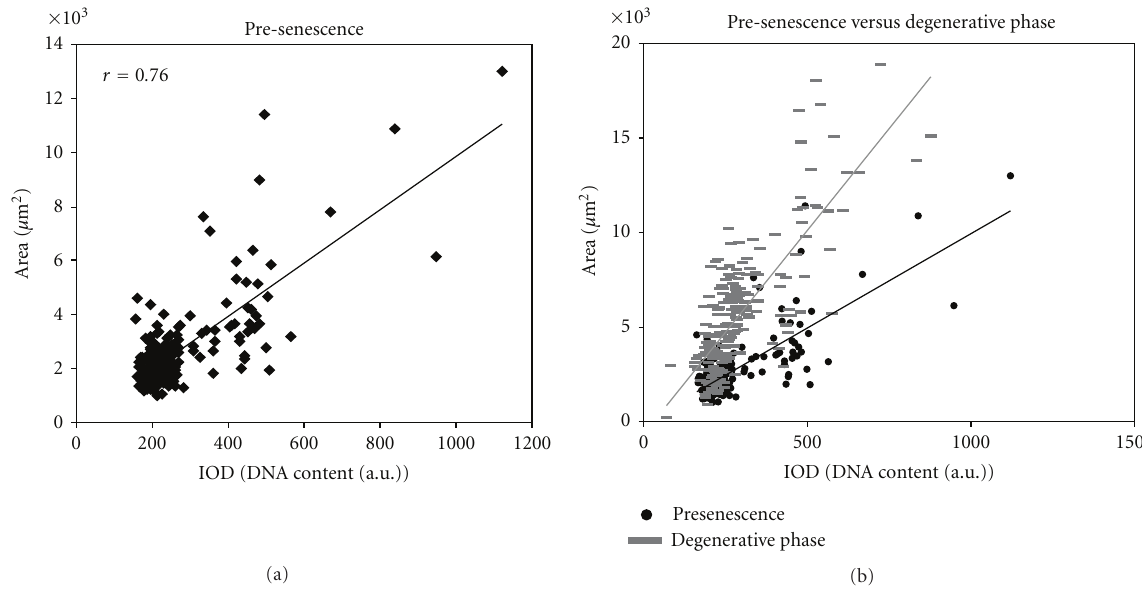
Figure 6: The relationship between the nuclear area and the DNA content (IOD) per each cell nucleus in: (a) a typical sample of presenescence phase and (b) the comparison of the latter and a sample in the degeneration phase. It is seen that the nuclear size is increasing roughly proportionally to the DNA content in the presenescence phase, while in the degeneration phase, the nuclear size is much larger indicating to nuclear swelling.